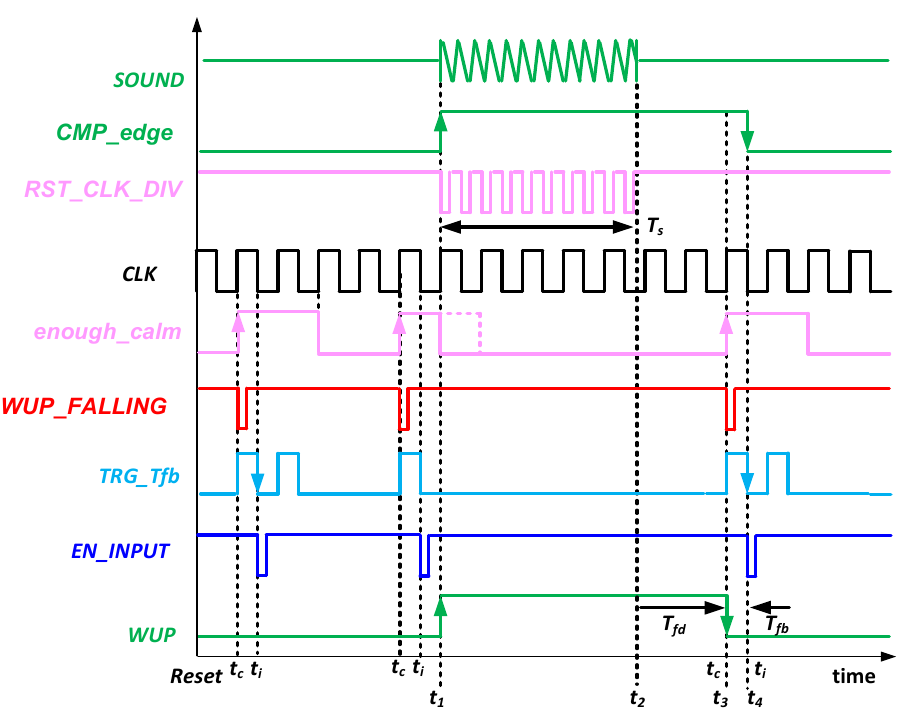
Figure 12. Clock diagram showing the operating principle of LOGIC.